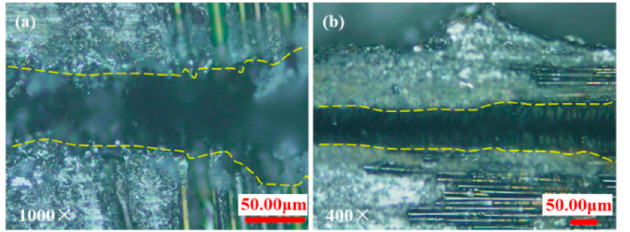
Figure 5. The morphologies of transverse scanning grooves in different regions. ( a ) Regions of matrix and longitudinal fiber arrangement; ( b ) regions of matrix and transverse fiber arrangement.